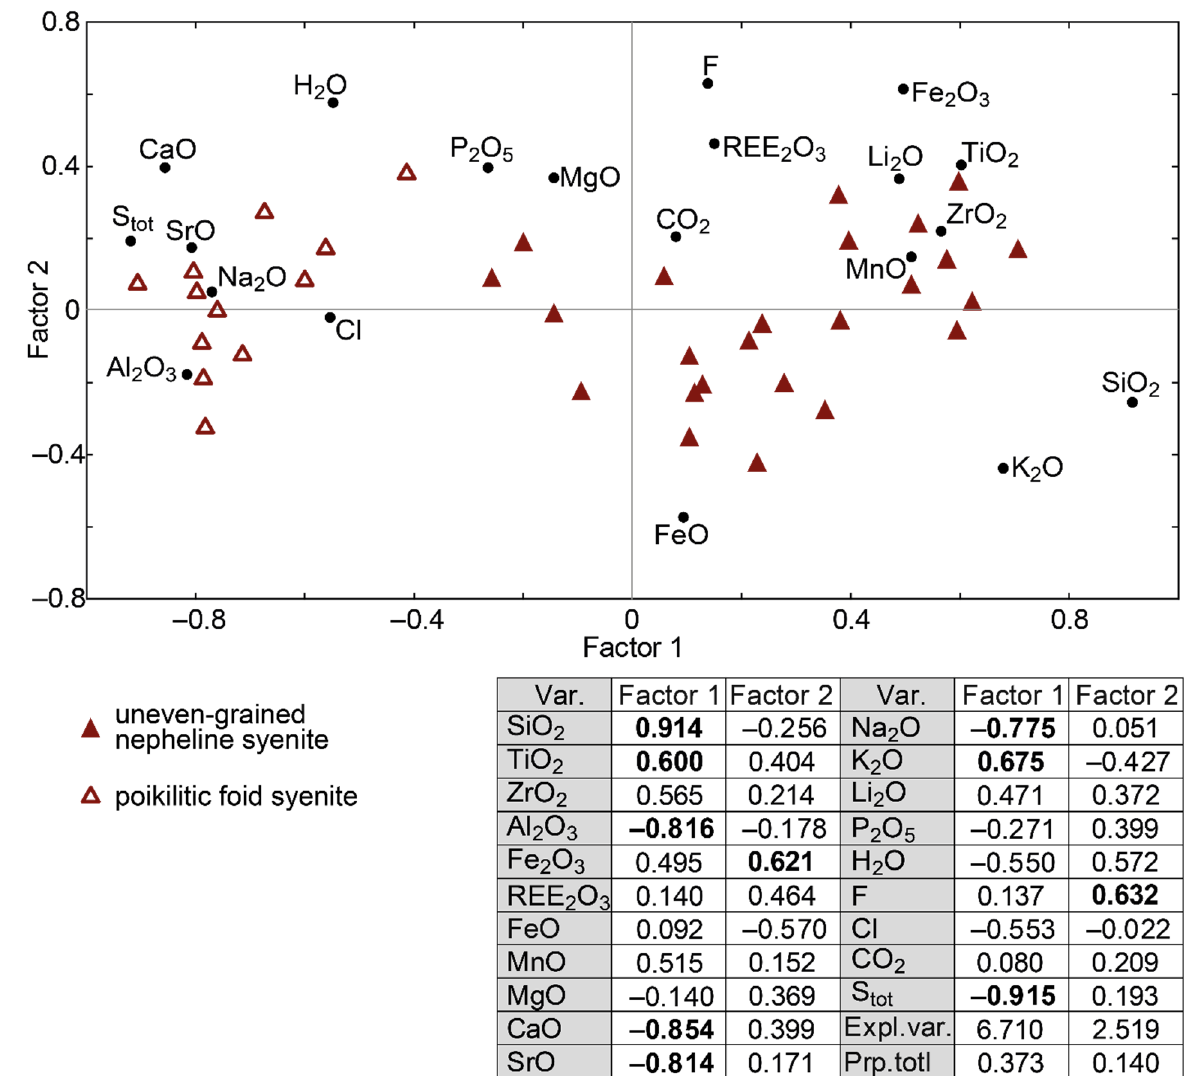
Figure 8. Results of factor analyses of data on the chemical composition of uneven-grained nepheline syenite and poikilitic foid syenite. Var.—variables; Expl.var.—explained variance; Prp.totl—proportion of total variance. Factor loadings > |0.6| are shown in bold.